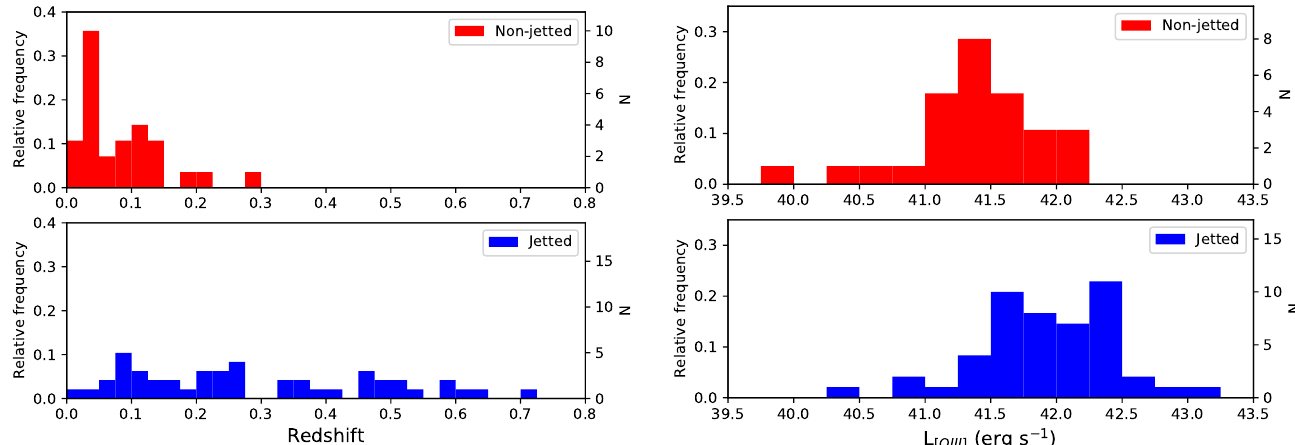
Figure 7. Left: Redshift distribution of the jetted (top panel) and the non-jetted (bottom panel) sources. Binning of 0.025. Right: distributions of the logarithm of the [O III] luminosity (in erg s − 1 ) for the jetted (top panel) and the non-jetted (bottom panel) sources. Binning of 0.25